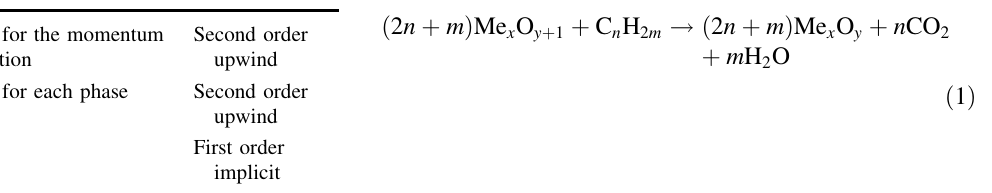
Table 1 Numerical parameters used in the present model